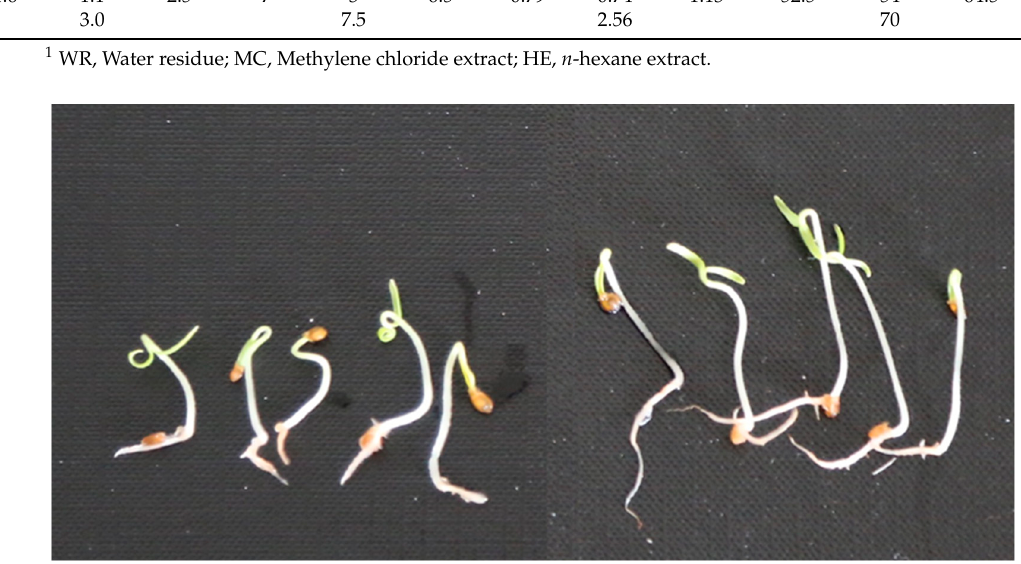
Figure 5. Inhibition of rootlet elongation of tomato plants induced by Es extract ( left ). Control (distilled H 2 O, right ).